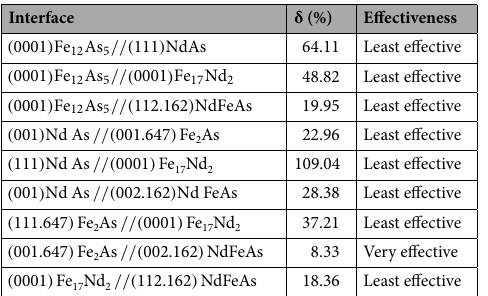
Table 6. Calculated planar lattice misfits among crystal faces of Nd–Fe–As